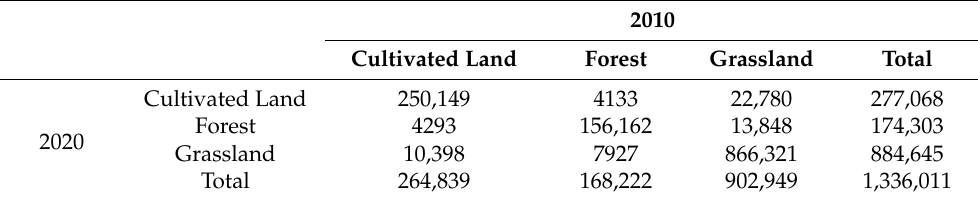
Table 3. Transfer matrix of vegetation types from 2010 to 2020 (unit: km 2